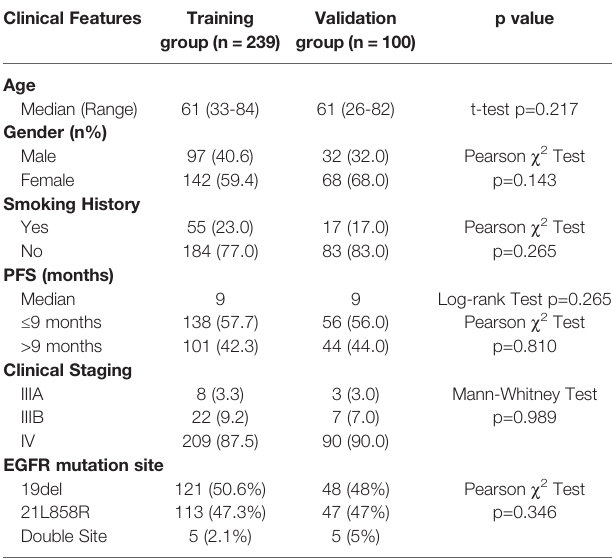
TABLE 1 | Comparison of clinical features in patients with PFS